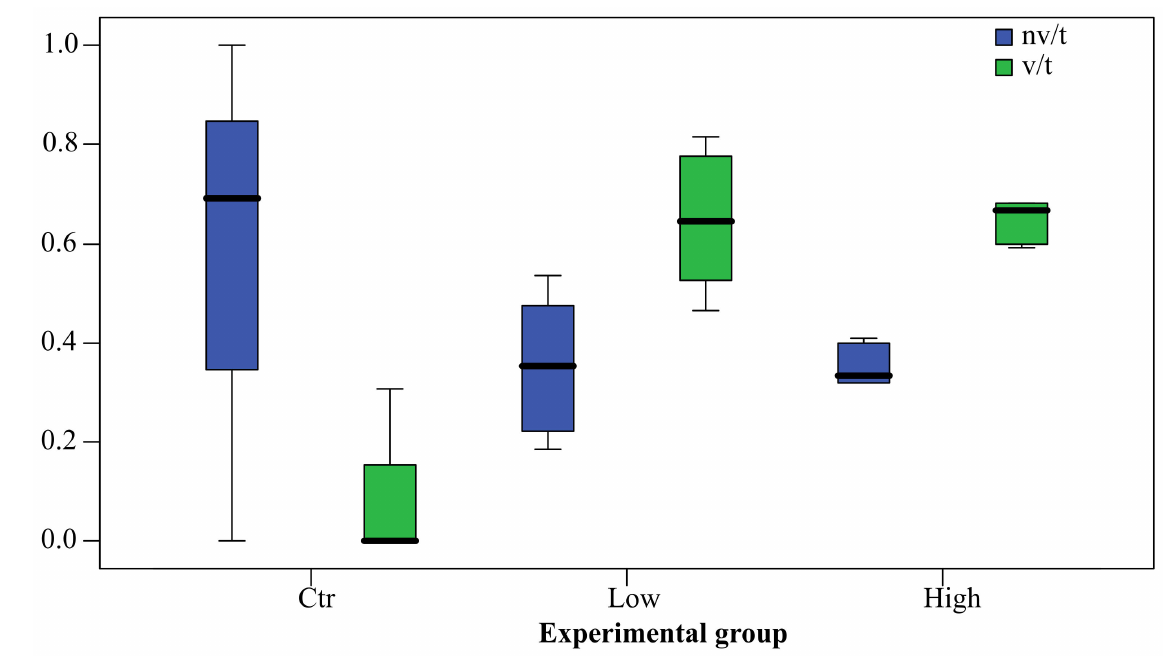
Figure 3. Box plot of the relative follicles number (in ordinate) according to morphology (nv/t = not vesiculated/total, v/t = vesiculated/total) and PFOA exposure group (Ctr, unexposed; Low concen- tration, 200 ng L − 1 PFOA; High concentration, 2 mg L − 1 PFOA). The bold line in the box represents the median and divides the box into a lower and upper quartile (25 percentile). The whiskers repre- sent the upper and lower outer quartiles and, as a consequence, the upper and lower 50 percentile starting from the